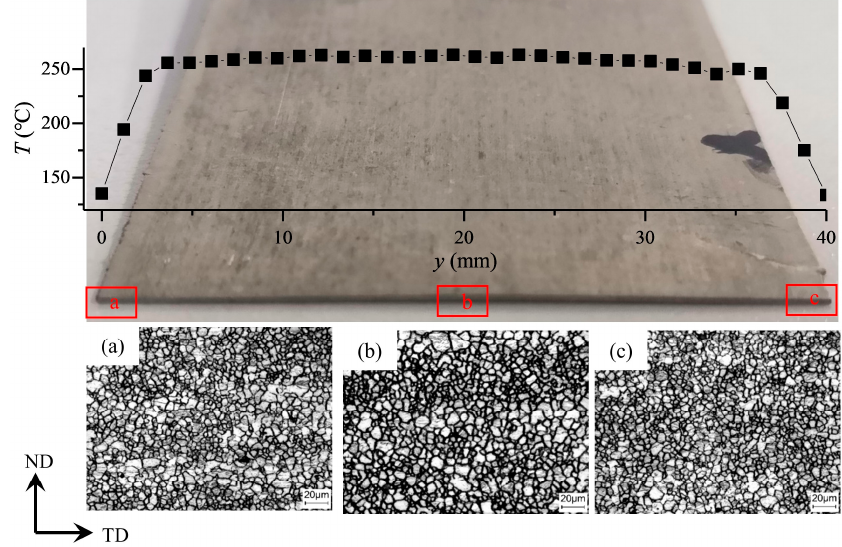
Figure 9. The optical microstructure in the entrance of rolling mill: ( a ) edge of the loop drive side; ( b ) center; ( c ) edge of the operating side.